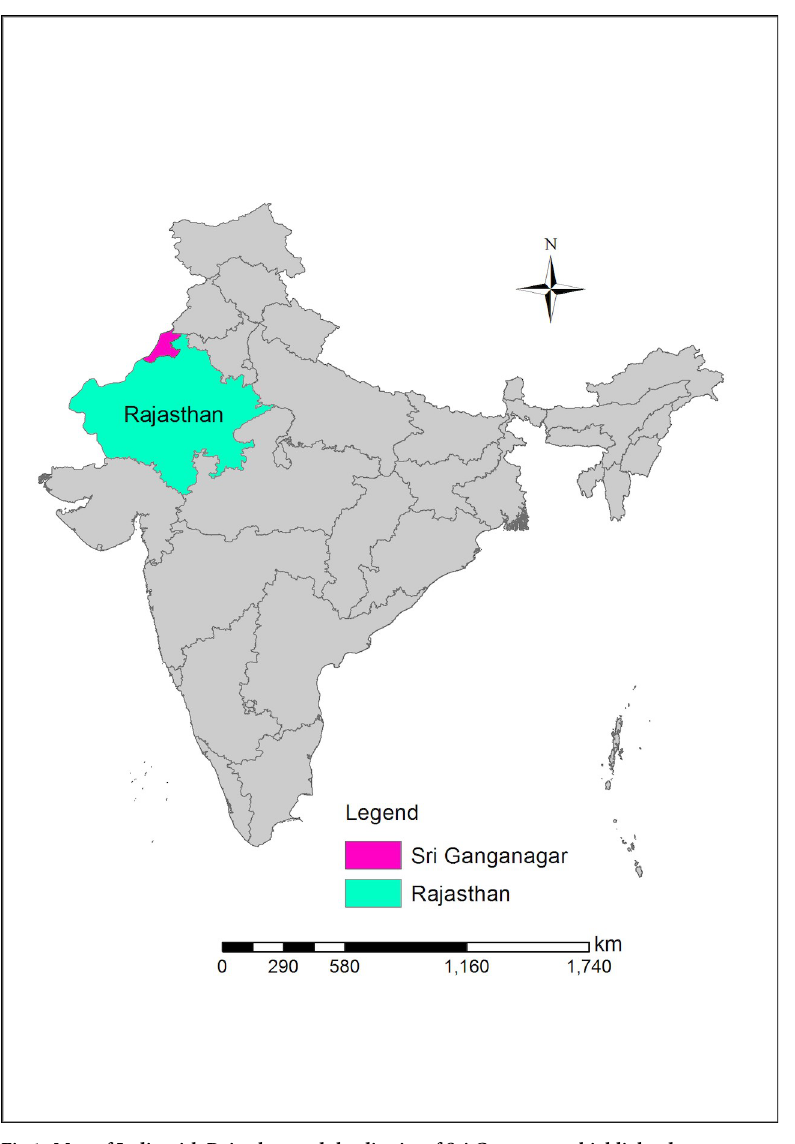
Fig 1. Map of India with Rajasthan and the district of Sri Ganganagar